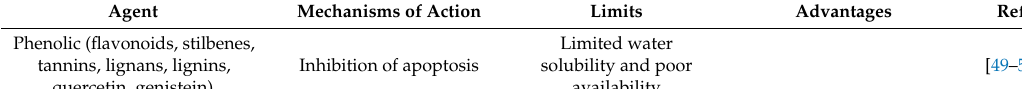
Table 1. Radioprotective agents able to reduce the harmful e ff ects of the